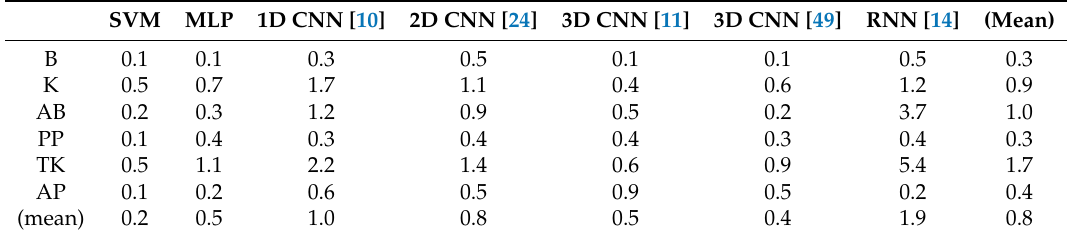
Table 3. Per-class percentage of errors for each method, aggregated over transductive experiments with F/frame images (first part of the HTC experiment).